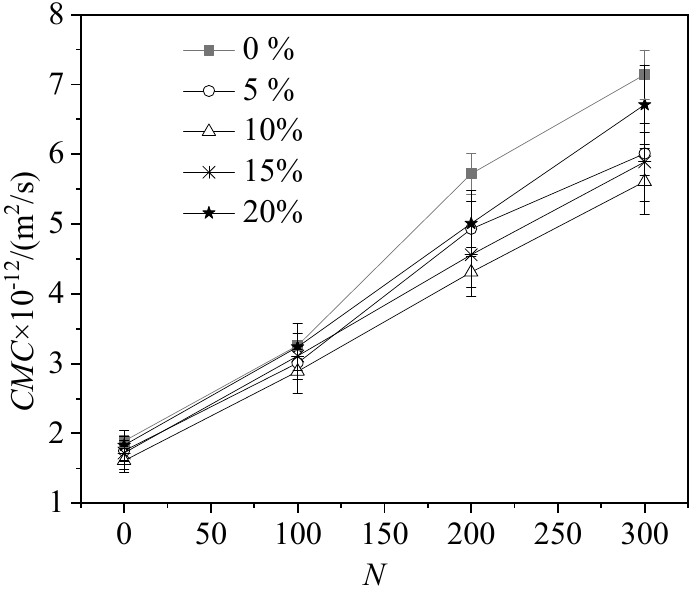
10 of 16 Table 5. Fitting parameters of mechanical strength loss rates and the number of NaCl freeze–thaw cycles ( N ). Equation a b R 2 (cid:1858) (cid:3047) = (cid:1853)(cid:1840) (cid:2870) + (cid:1854)(cid:1840) + (cid:1855)